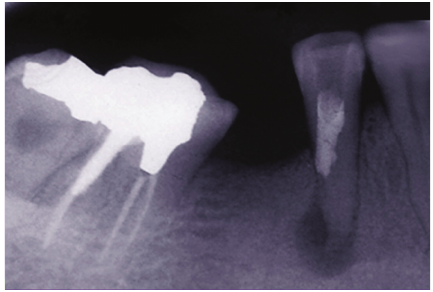
Figure 3: Calcium enriched mixture cement was used to seal the